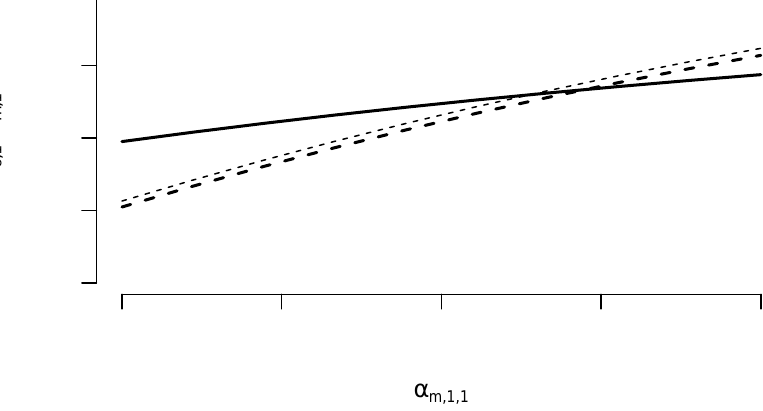
Figure 3. Shifts of the supply curves by increasing volatility of the alternative investment. Investor’s supply with investment horizon T = 1 (dashed) and T = 2 (solid). Thinner lines correspond to the case low volatility of the alternative investment; thicker lines correspond to high volatility. The x -axis shows α m ,1,1 , the investor’s position in the put option on the rainfall in Changde during May ( CR May ,1 ) with strike K = 100; the y -axis shows W 0,1 ( α m ,1 ) , the price for which the investor is willing to sell such an option, where α m ,1 = ( α m ,1,1 , α m ,1,2 ) (cid:62) and while α m ,1,2 , the position in the other put option on the rainfall in Enshi during April and May ( CR May ,2 ) is kept